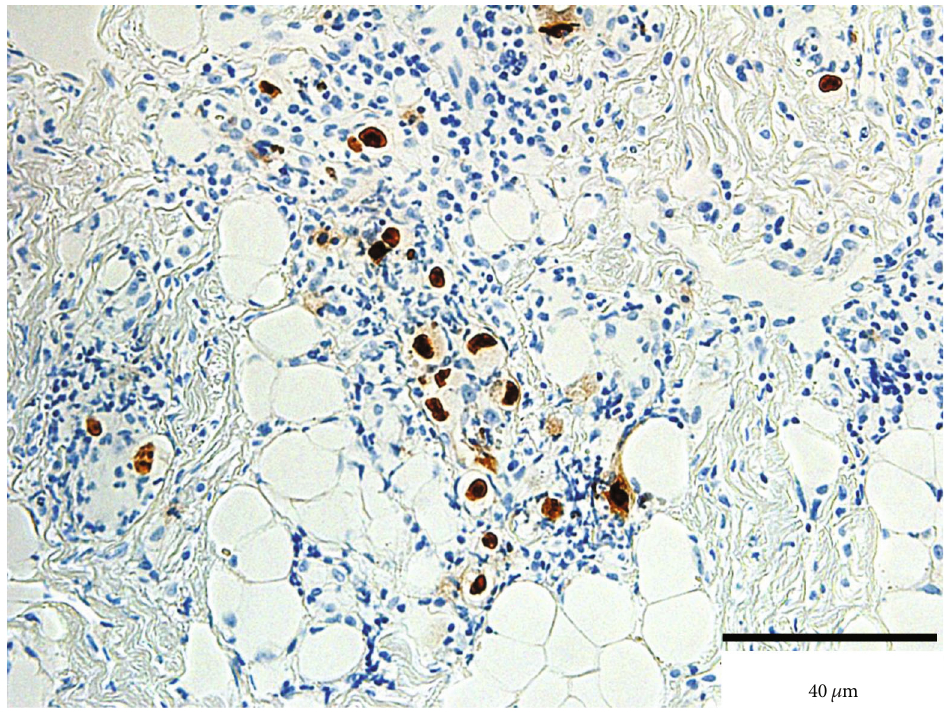
Figure 3: Findings from immunohistochemical staining of the specimen obtained from ulcer biopsy. Anticytomegalovirus antibodies are detected in the nuclei of infected cells. Bar: 40 μ m.